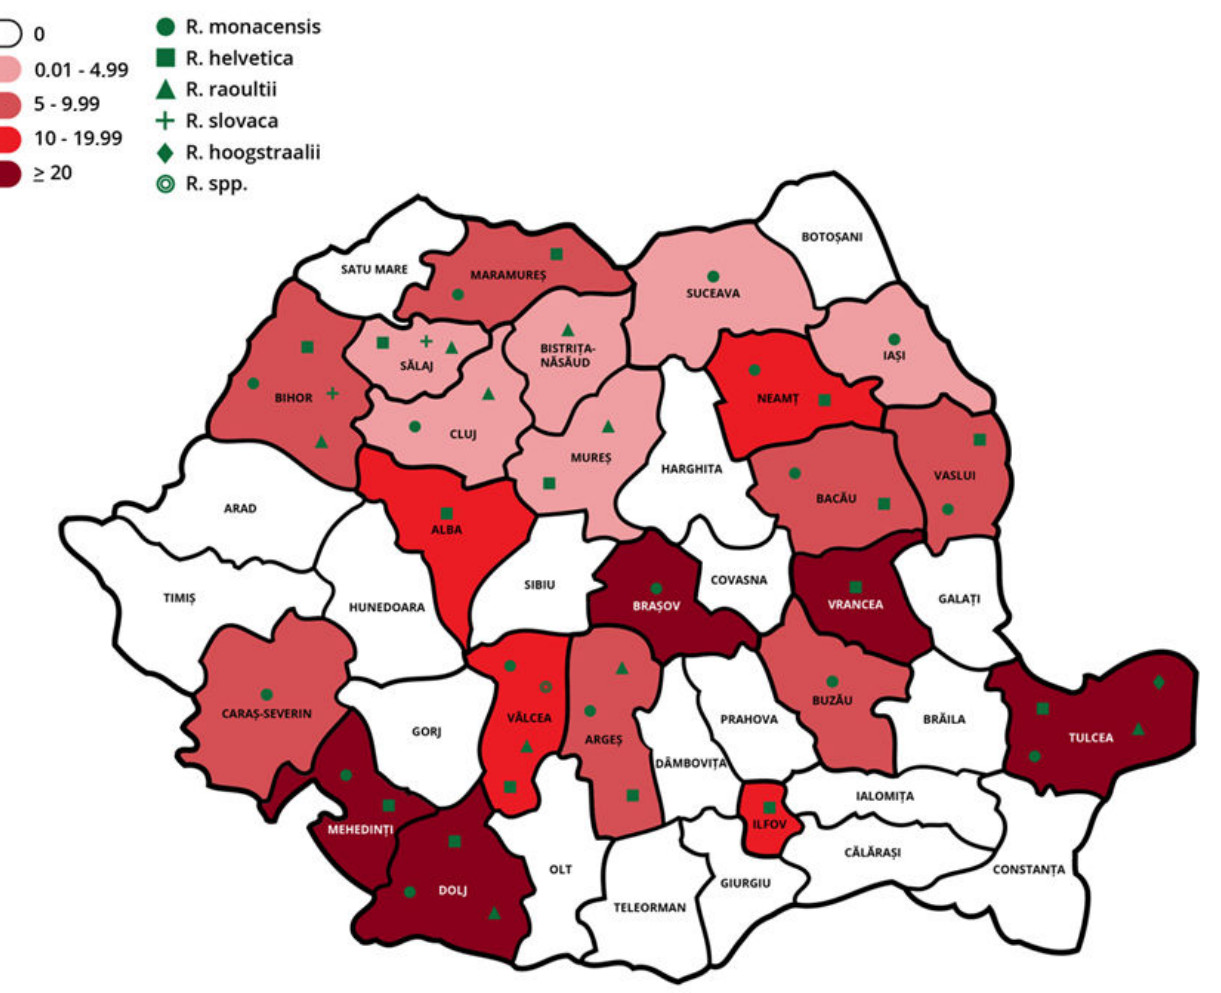
Figure 1. The prevalence, diversity, and geographic distribution of Rickettsia spp. in ticks in